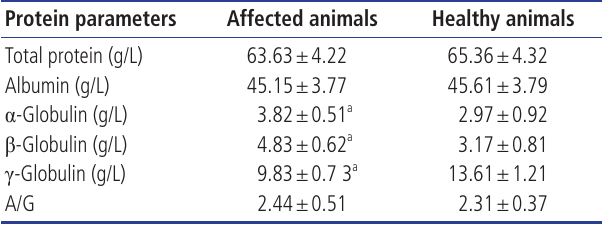
Table 3. Serum protein contents in Qianbei-Pockmarked goats Protein parameters